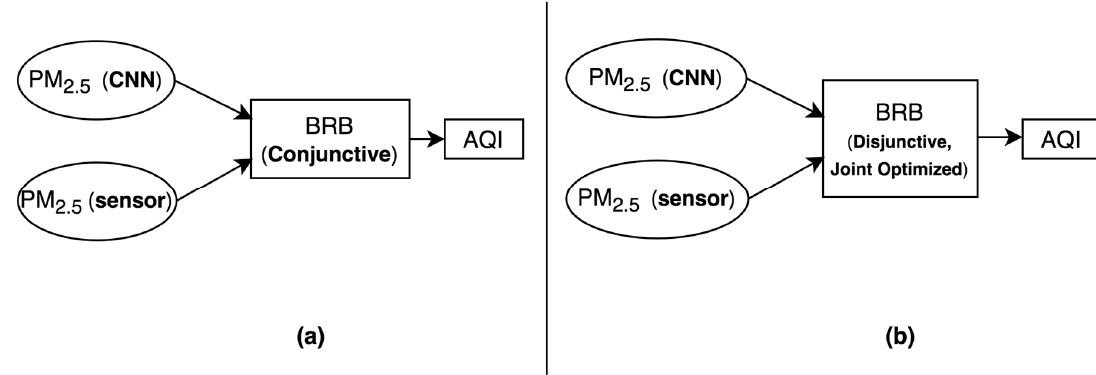
Figure 4. General methodological scheme of our proposed system: ( a ) with Conjunctive Belief Rule Base (BRB); ( b ) with Disjunctive, Joint Optimized BRB.